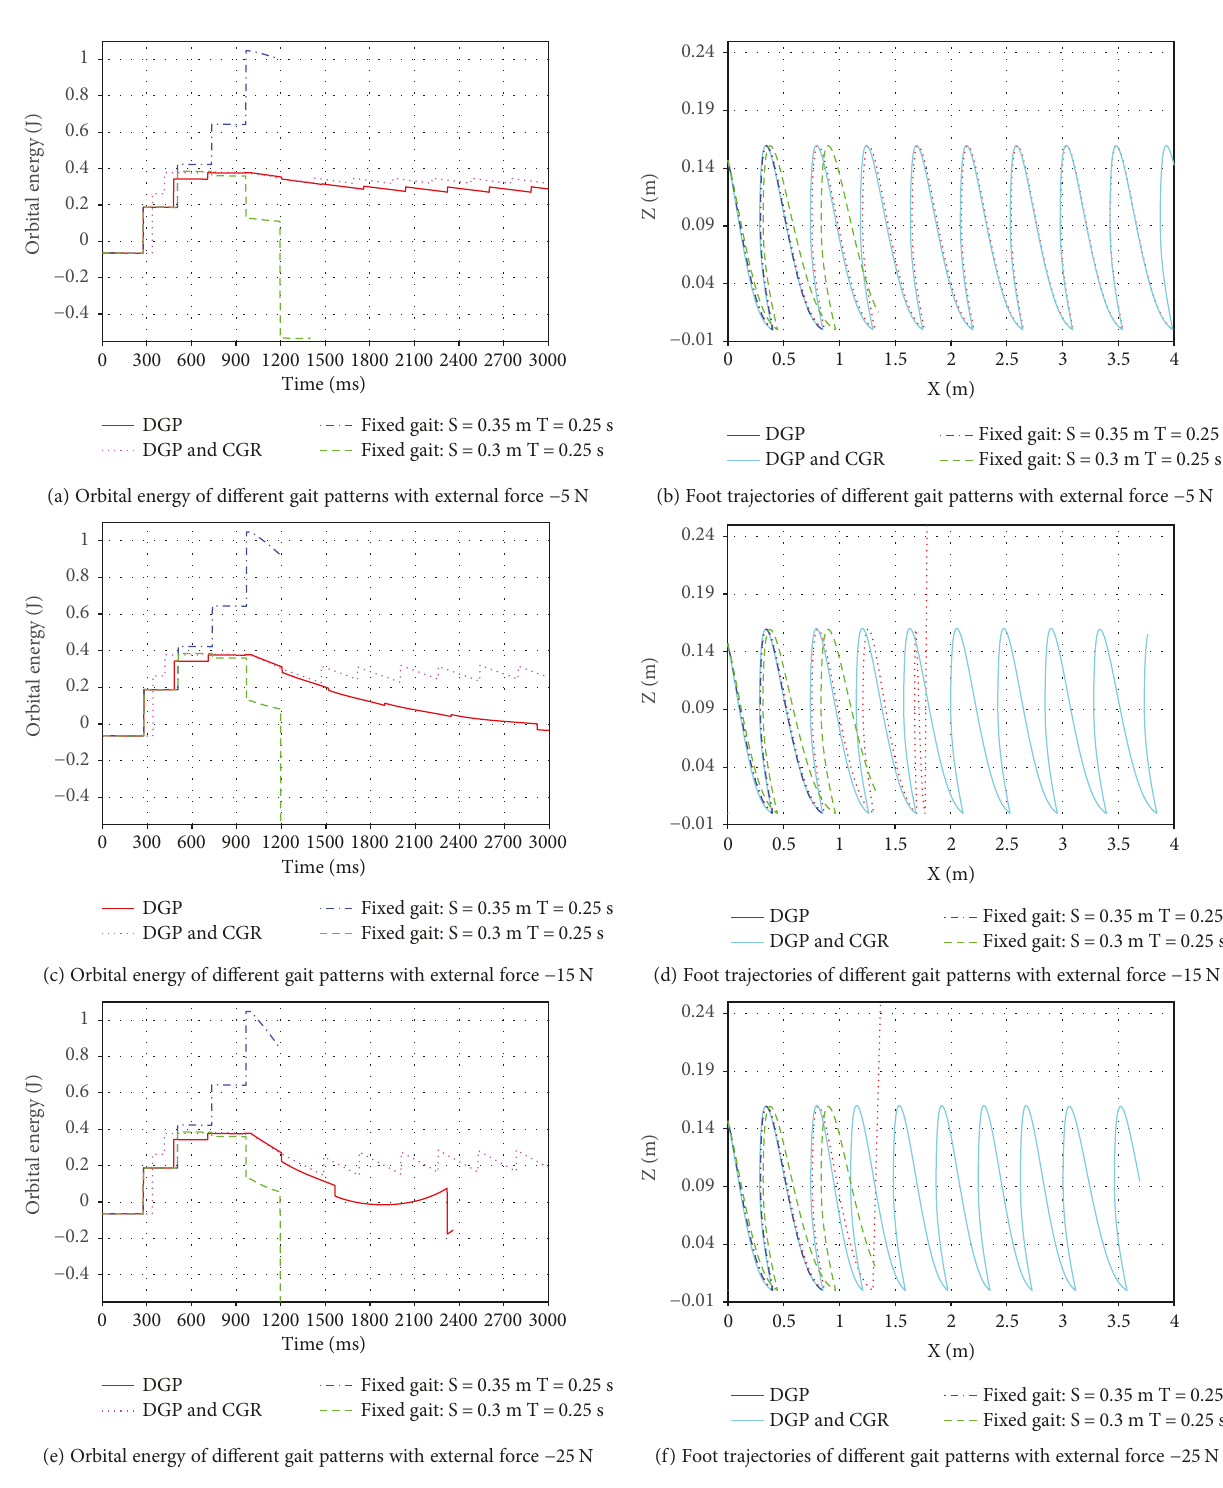
Figure 8: Experimental results of di ff erent gait patterns with external force ( − 5N, − 15N, and − 25 Di ff erent disturbance: − 5 N, − 15 N, − 25 N, 5 N, 15 N, targeting orbital energy is set to be 0 4 J . Four gait patterns are compared in our experiment: and 25 N in sagittal plane is posed on LIP from 500 ms Gait with fi xed parameters: S = 0 35, T = 0 25 . to 2000 ms. A trail ends if the model falls down during Gait with fi xed parameters: S = 0 3, T = 0 25 . walking. Orbital energy and foot transition of di ff erent Gait generated by DGP. gait patterns are recorded for evaluating the ability to Gait generated by DGP combined with CGR. keep balance.